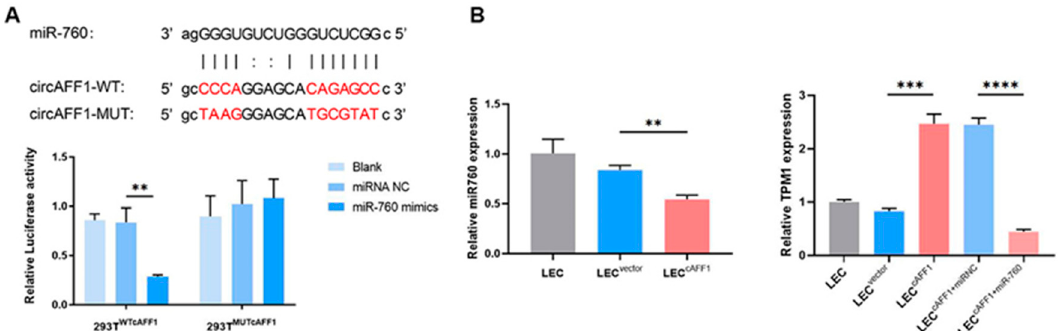
Figure 5. CircAFF1 increased TPM1 expression by sponging miR-760. ( A ) The upper panel: the predicted binding sequences of circAFF1 and miR-760; the lower panel: the relative luciferase reporter activity of 293T WTcAFF1 and 293T MUTcAFF1 following transfection with miR-760 mimics and control mimics. ** p < 0.01. ( B ) qPCR showed decreased expression of miR-760 in LEC cAFF1 . The expression of TPM1 was increased in LEC cAFF1 and decreased in LEC cAFF1 with miR-760 mimics. ** p < 0.01, *** p < 0.001, **** p < 0.0001.